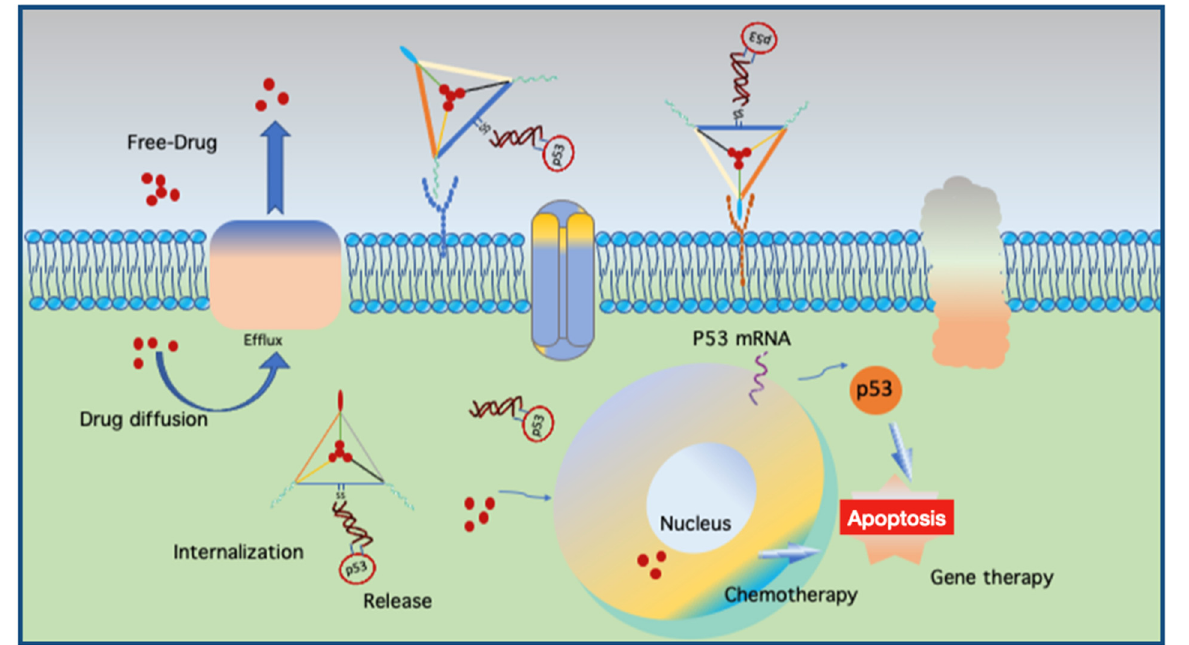
Figure 4. The molecular mechanism involved in circumventing multiple-drug resistant (MDR) cells and the dual therapy of cancer cells. MDR cells excrete drugs via an efflux pump and the DNA nanostructure can deliver the drug into the cell via cellular uptake through endocytosis. The drug is released through pH-dependent conditions and subsequently delivered to the nucleus to induce apoptosis. DNA nanostructures equipped with both drugs and tumor therapeutic genes can co- deliver dual chemotherapeutic and gene therapeutic effects to MDR cancer cells. Illustration inspired from [50]. Table 2. DNA nanostructures in cancer therapy.